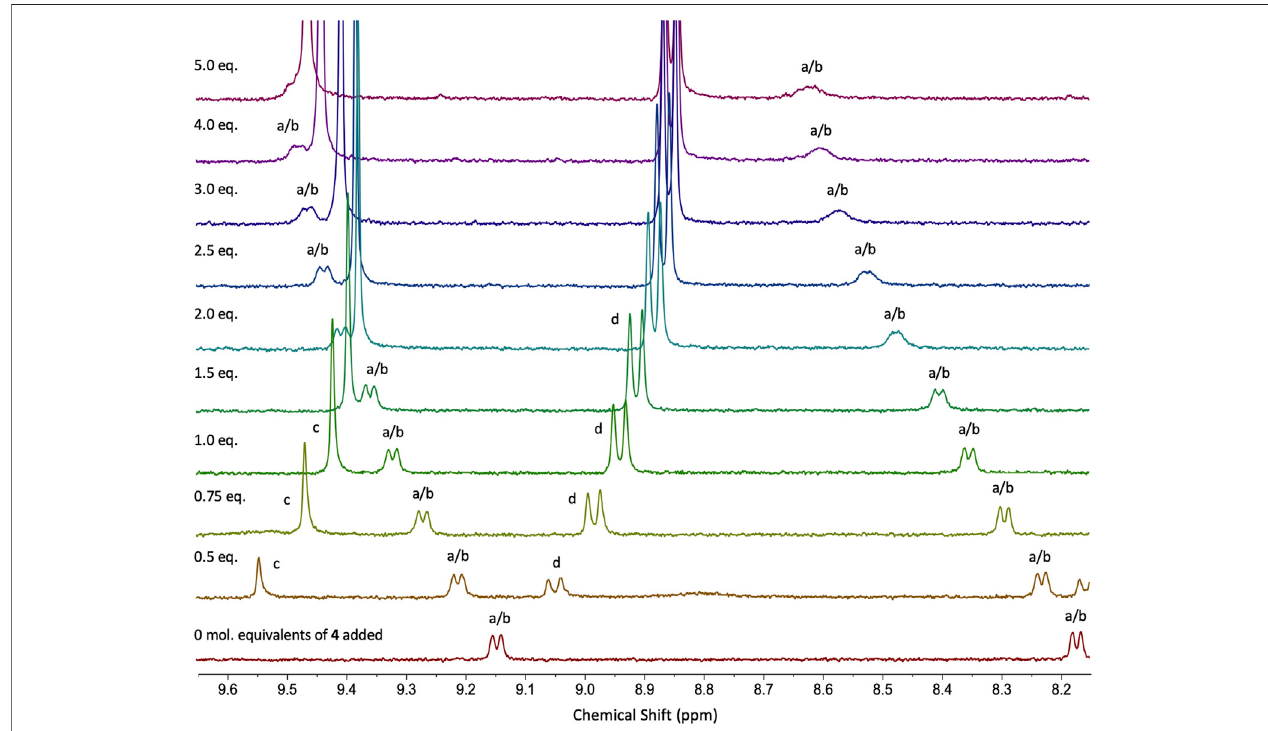
(cid:129) (cid:129) (cid:129) (cid:129) 3 and 1H + 3 and (B) 2 4 and 2H + 3 toward experimentally elucidating the charge contribution to these